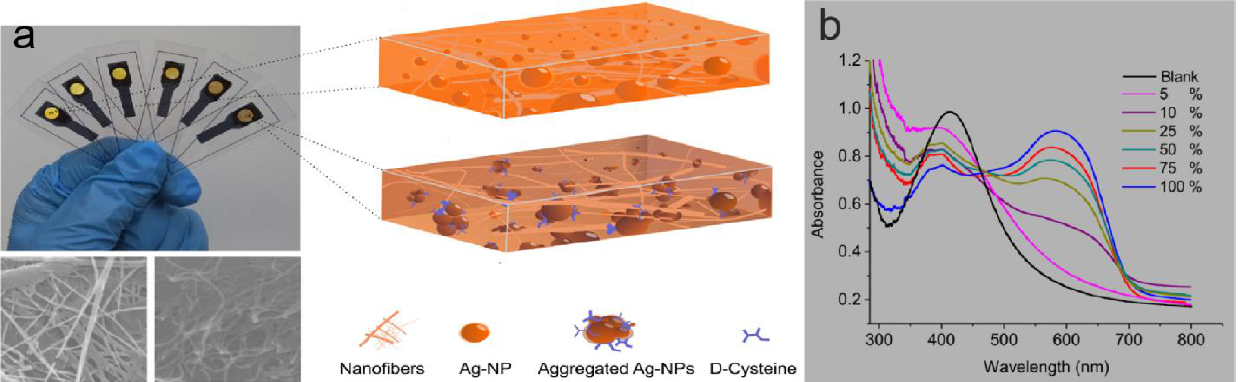
Figure 9. ( a ) The microcuvette modulation for spectrophotometric measurements at the solid plat- form for the same enantiomeric percentage range of D-cysteine. Reprinted with permission from Ref. [119]. Copyright 2018, Talanta (Oxford). ( b ) The recorded UV-Vis spectra for the corresponding microcuvettes. Reprinted with permission from Ref. [119]. Copyright 2018, Talanta